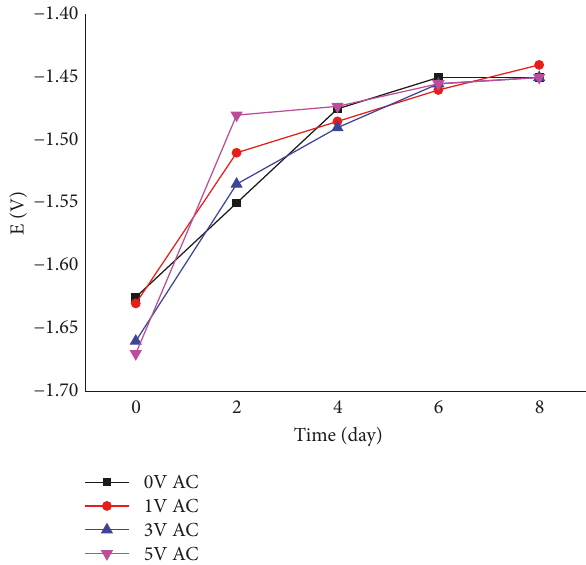
Figure 2: The open circuitpotential of magnesium sacrificial anode under different AC interference voltages at an ambient temperature of 20 ∘ C in the test